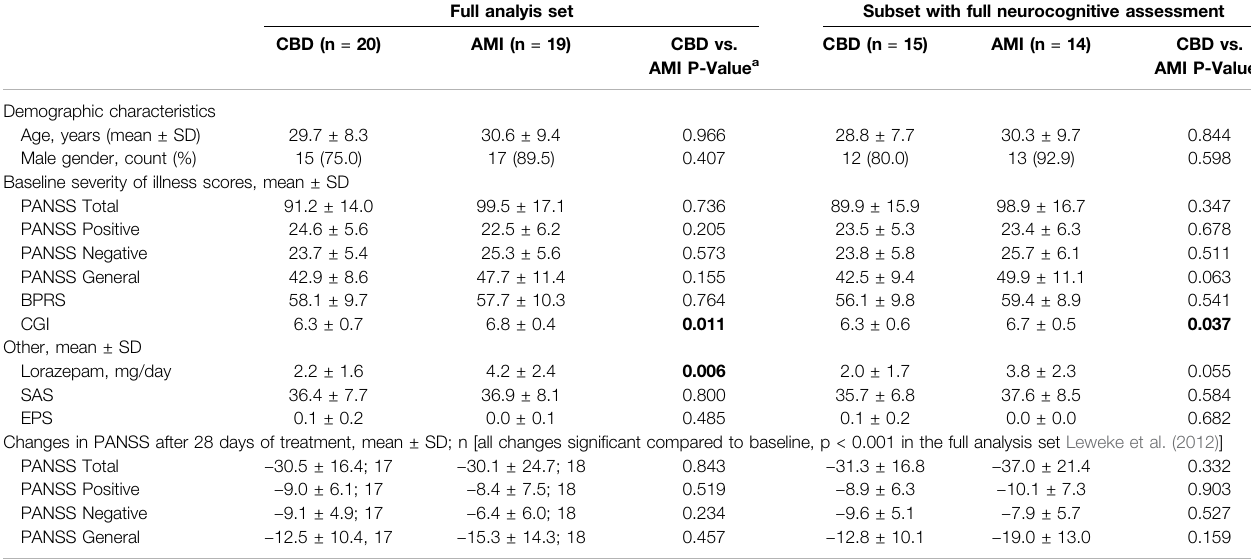
TABLE 1 | Characteristics of the patient